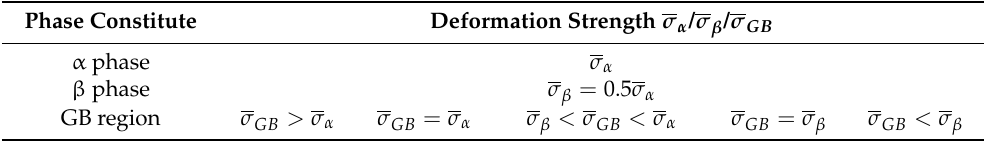
Table 2. Strength relationship of α grain, β phase and GB region of TA15 titanium alloy. Deformation Strength σ α / σ β / σ